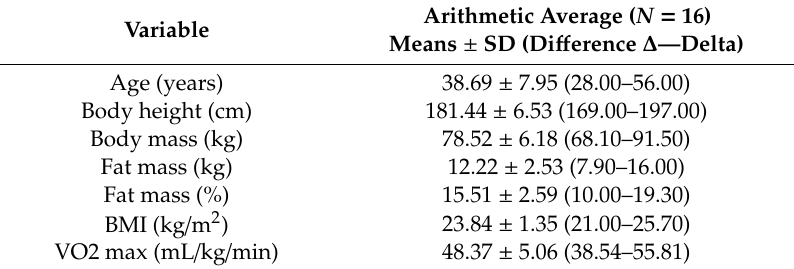
Table 2. Anthropometric measurements and VO2 max